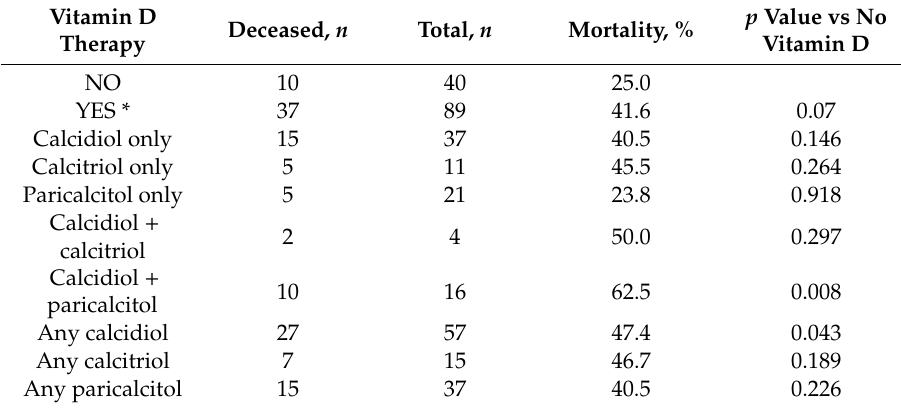
Table 2. Distribution of vitamin D formulations and